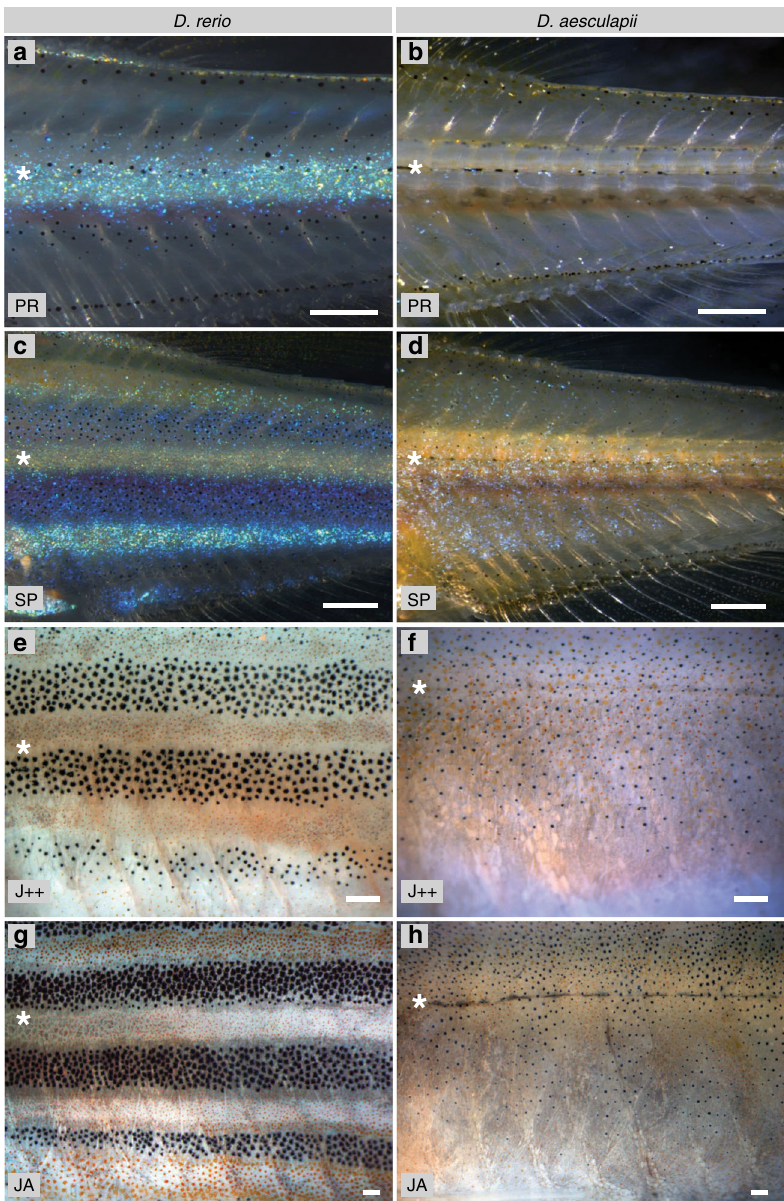
Fig. 2 Development of colour patterns in D. rerio and D. aesculapii . a D. rerio fi sh at stage PR, iridophores (arrowhead) emerge along the horizontal myoseptum (asterisk) to form the fi rst light stripe. b D aesculapii fi sh at stage PR. c D. rerio at stage SP, the fi rst light stripe is fl anked dorsally and ventrally by emerging dark stripes. d D. aesculapii at stage SP, iridophores emerge in a scattered fashion. e D. rerio at stage J ++ , light stripes are covered by compact xanthophores. f D. aesculapii at stage J ++ , melanophores and xanthophores broadly intermix. g D. rerio at stage JA, the stripes are fully formed. h D. aesculapii at stage JA, melanophores and xanthophores sort out loosely into vertical bars of low contrast; no dense iridophores are visible between the dark bars. a – d Incident light illumination to highlight iridophores, e – h bright fi eld illumination to visualise xanthophores and melanophores. All pictures are representative for the corresponding species and stages ( n ≥ 3). Staging of animals according to Parichy et al. 83 . PB (pectoral fi n bud, 7.2 mm SL). SP (squamation posterior, 9.5 mm SL). J ++ (juvenile posterior, 16 mm SL). JA (juvenile-adult, >16 mm SL). Scale bars correspond to 250 μ display slightly stronger pattern aberrations than those seen in the previously identi fi ed alleles (Fig. 4c) 36 . melanophore spots (Fig. 4a, b). Both connexins are thought to form heteromeric gap junctions involved in the interaction between xanthophores and melanophores 40,42 . Missense muta- tions in Igsf11 ( seurat ) 36 , which codes for a cell adhesion mole- stripes with some mixing of melanophores and xantho- cule, also cause a spotted pattern. We generated a frame-shift phores 35,37,38 . So far, fi ve Kcnj13 alleles, all of which are mutation in exon 3 of Igsf11 in D. rerio . This mutation leads to a dominant, have been identi fi ed in D. rerio in several independent truncation of the protein at the end of the fi rst Ig-domain and is, genetic screens (Supplementary Figs. 4 and 5) 37,38,40,56,57 . We presumably, a functional null allele. Fish heterozygous for this used the CRISPR/Cas9 system to generate novel mutations in mutation show no mutant phenotype, whereas homozygous fi sh Kcnj13 in D. rerio . A six-base pair in-frame deletion in exon 1,